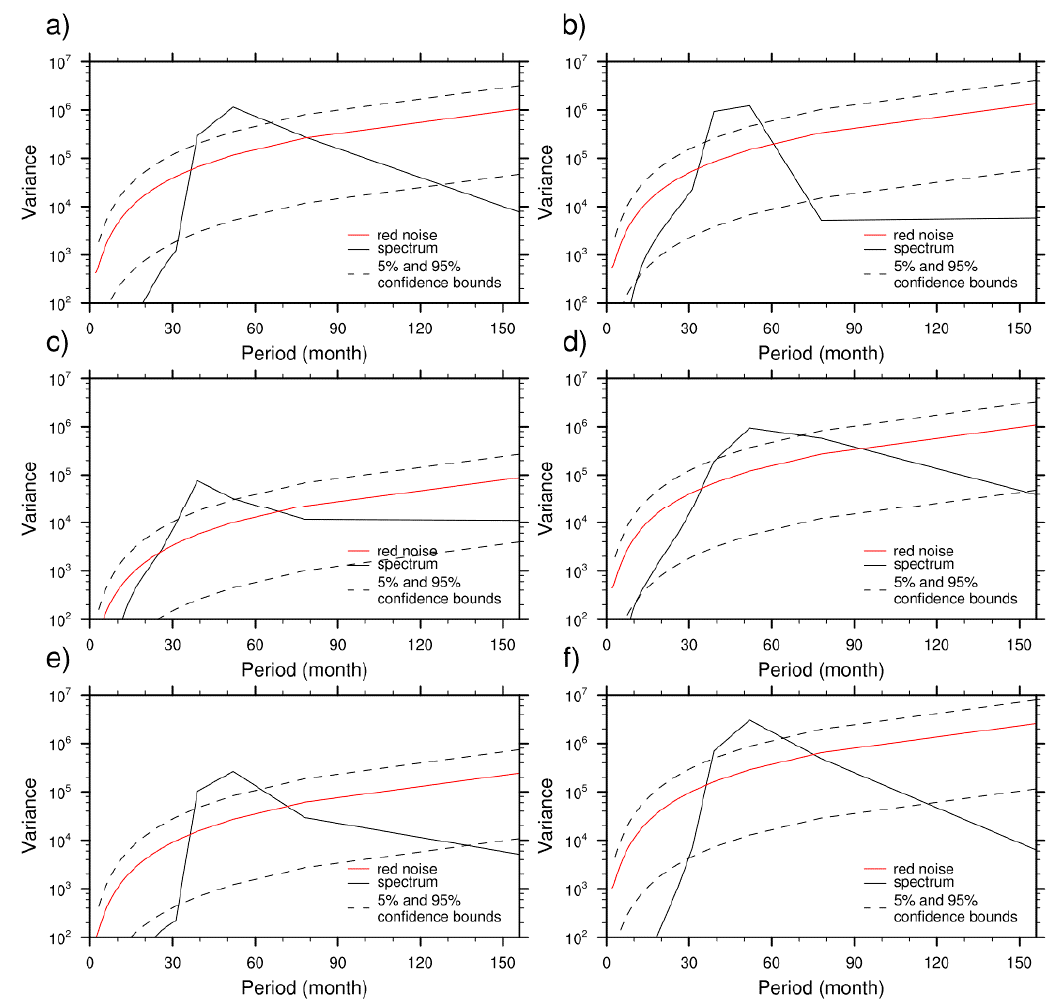
Figure 5. Spectra for bandpass-filtered first EOF time series of SLP from the ERA5 dataset ( a ) and selected models (red line is the red noise, and dashed line is the 5% and 95% confidence bounds). Models ( b - f ) are the same as Figure 3 ( b - f ).